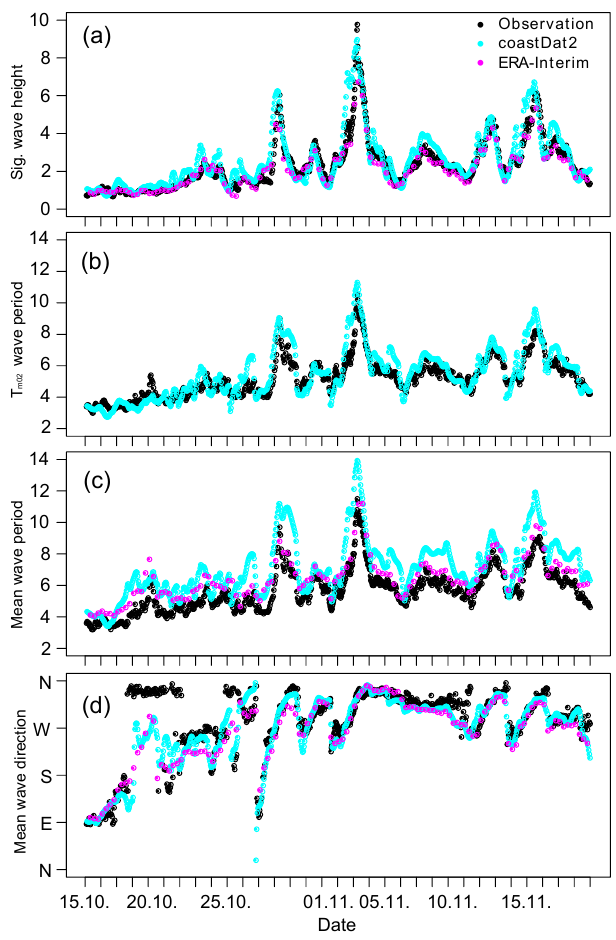
Figure 10. Time series of significant wave height (in metres) (a) , T m02 (in seconds) (b) mean wave period (in seconds) (c) and mean wave direction (in degrees) (d) at FN1 for the period 15 October 2006, 00:00UTC to 15 November 2006, 00:00UTC. Observations are shown in black (a–d) , the coastDat2 hindcast is shown in cyan (a–d) and the ERA-Interim data are shown in magenta (a,c,d) .